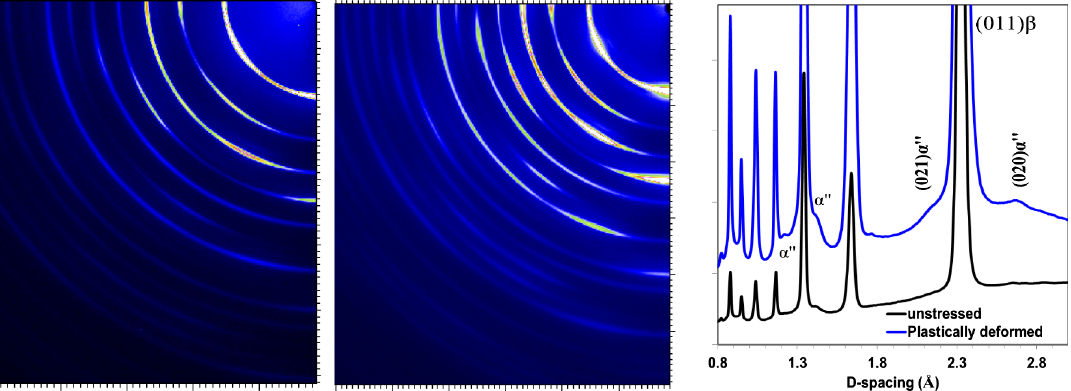
FIG. 19. Unstrained (left), plastically deformed (middle) and phase map of 90% cold-worked gum metal revealing α ″ transformations occurring during plastic deformation.